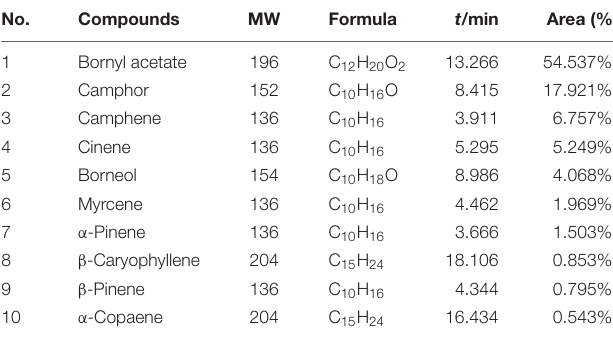
(0.54%) were detected in VOA. BA was considered as the representative compound of